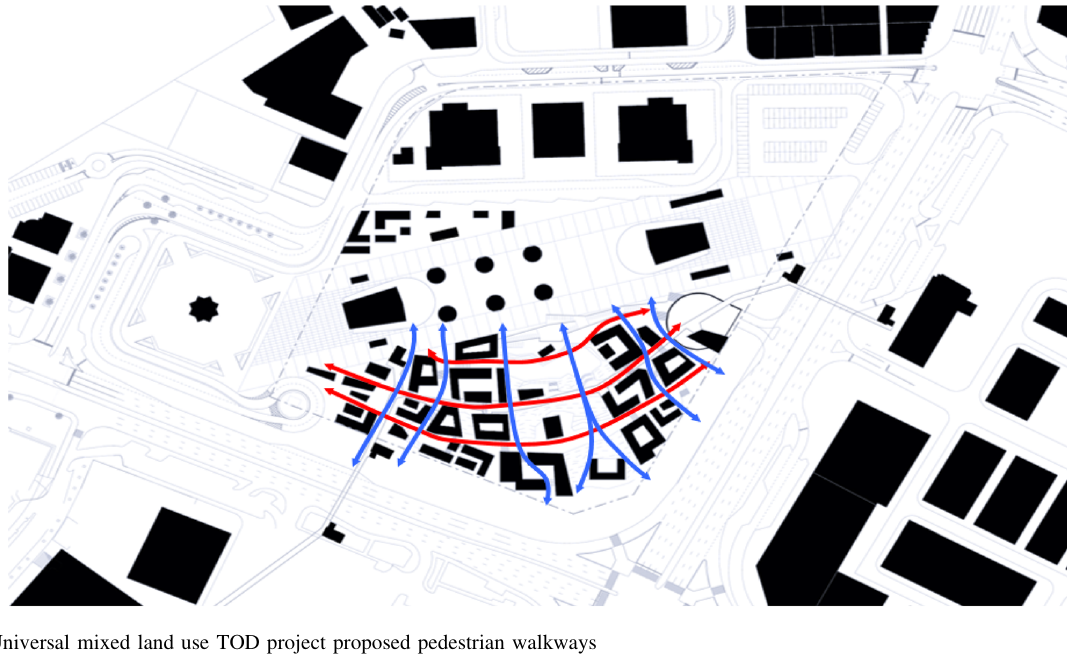
Fig. 5 Universal mixed land use TOD project proposed pedestrian walkways